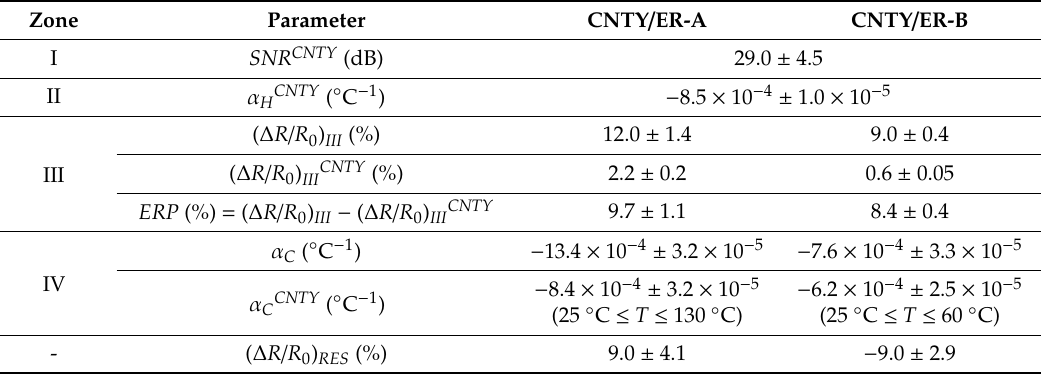
Table 3. Characterization parameters extracted from experiments of CNTY / ER-A and CNTY / ER-B (average and one standard